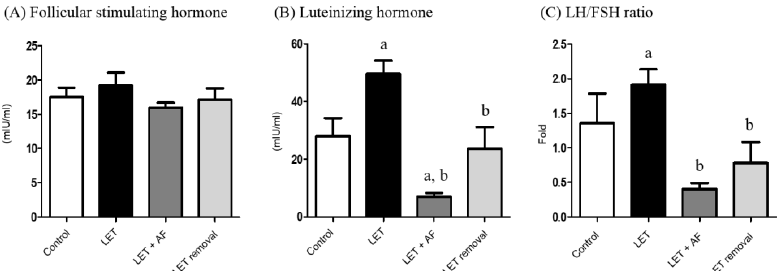
Figure 3. Effect of 2-week treatment with A. fistulosum root extract on plasma gonadotropin levels in letrozole-induced PCOS rats. Plasma steroid hormonal levels such as ( A ) FSH, ( B ) LH and ( C ) LH/FHS ratios were measured using a competitive enzyme-linked immunosorbent assay (ELISA) kit. All values represent means ± SEM; n = 5–10 per group; a p < 0.05 vs. Control group b p < 0.05 vs. LET group. AF: A. fistulosum., LET: letrozole.